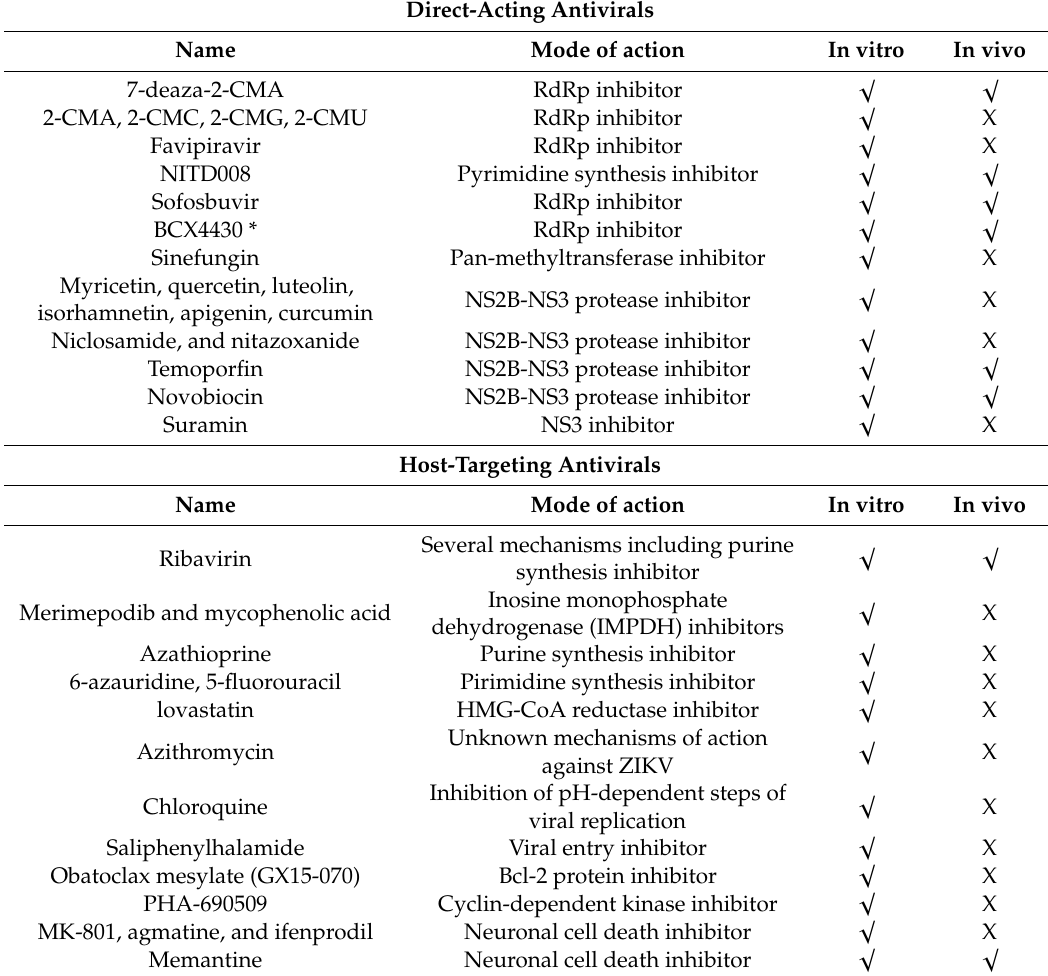
Table 2. Summary of the di ff erent antiviral options described in this